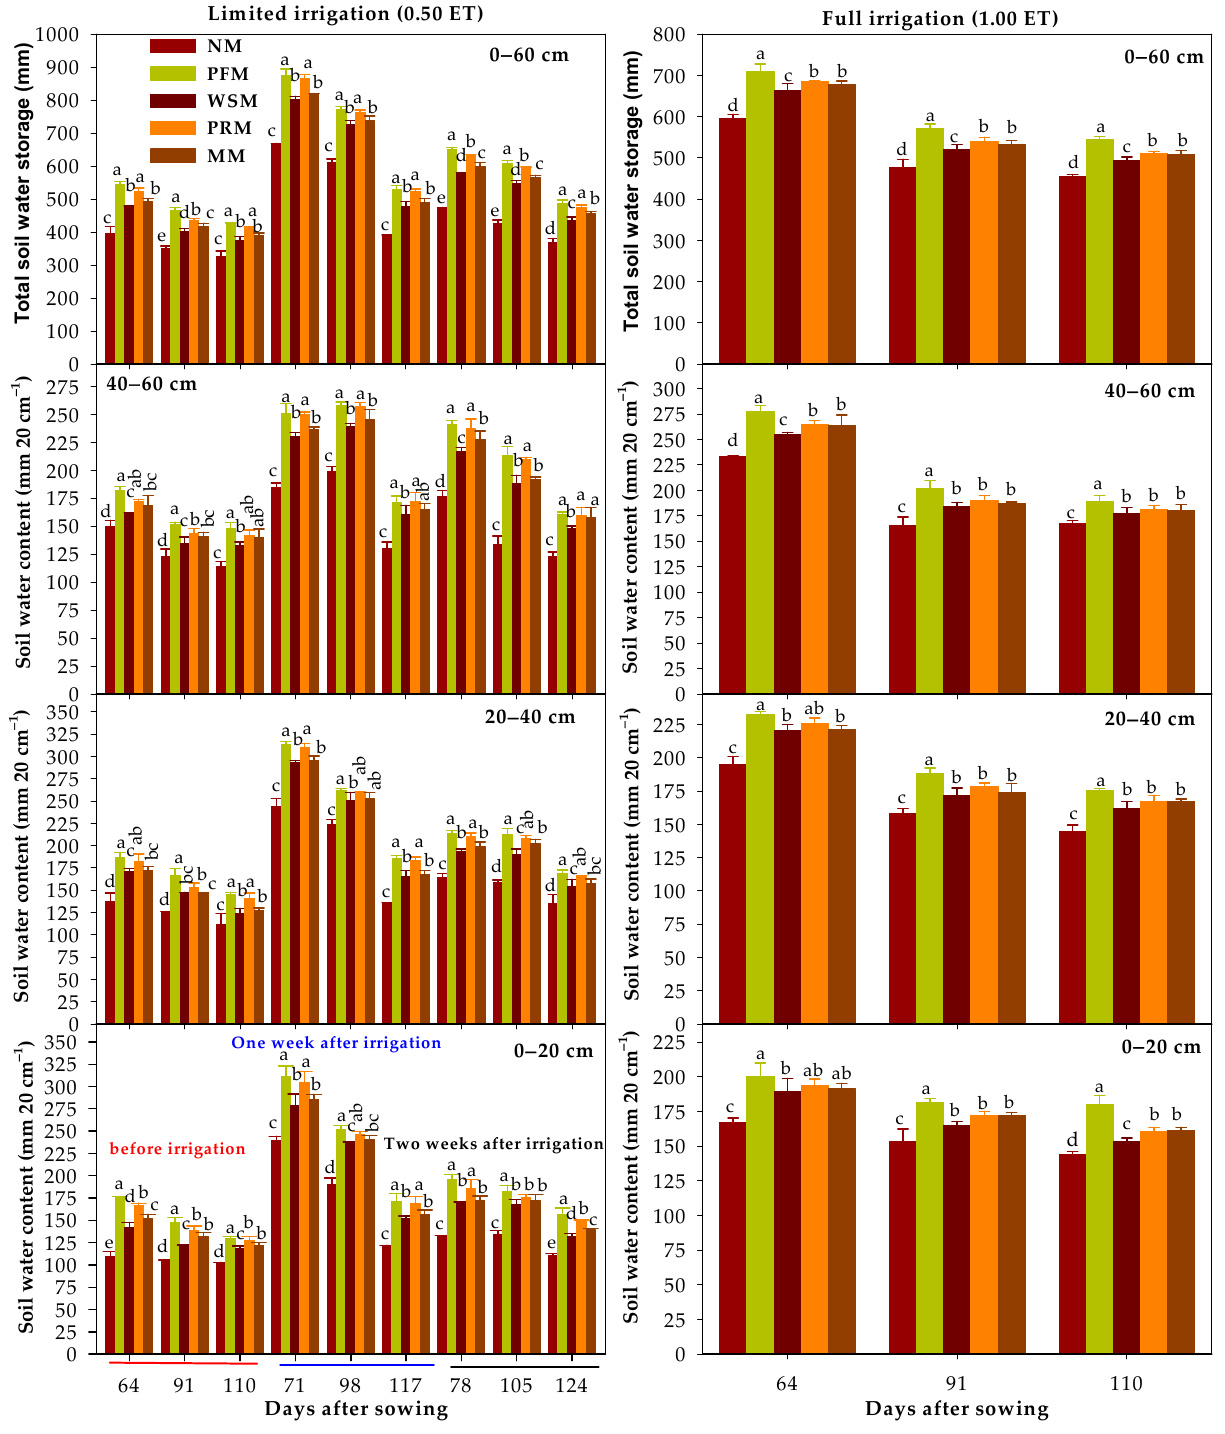
Figure 3. Comparison of soil water storage before irrigation, one week after irrigation, and two weeks after irrigation between different mulching practices at different soil depths under limited (LM)and full irrigation (FL) regimes. Bars with different letters are significantly different from each another on the basis of Duncan’s multiple range test at p ≤ 0.05. Abbreviations in the figure indicate no mulch (NM), plastic film mulch (PFM), wheat straw mulch (WSM), palm residues mulch (PRM), and a mixture of wheat straw and palm residues at 50/50 ratio (MM).